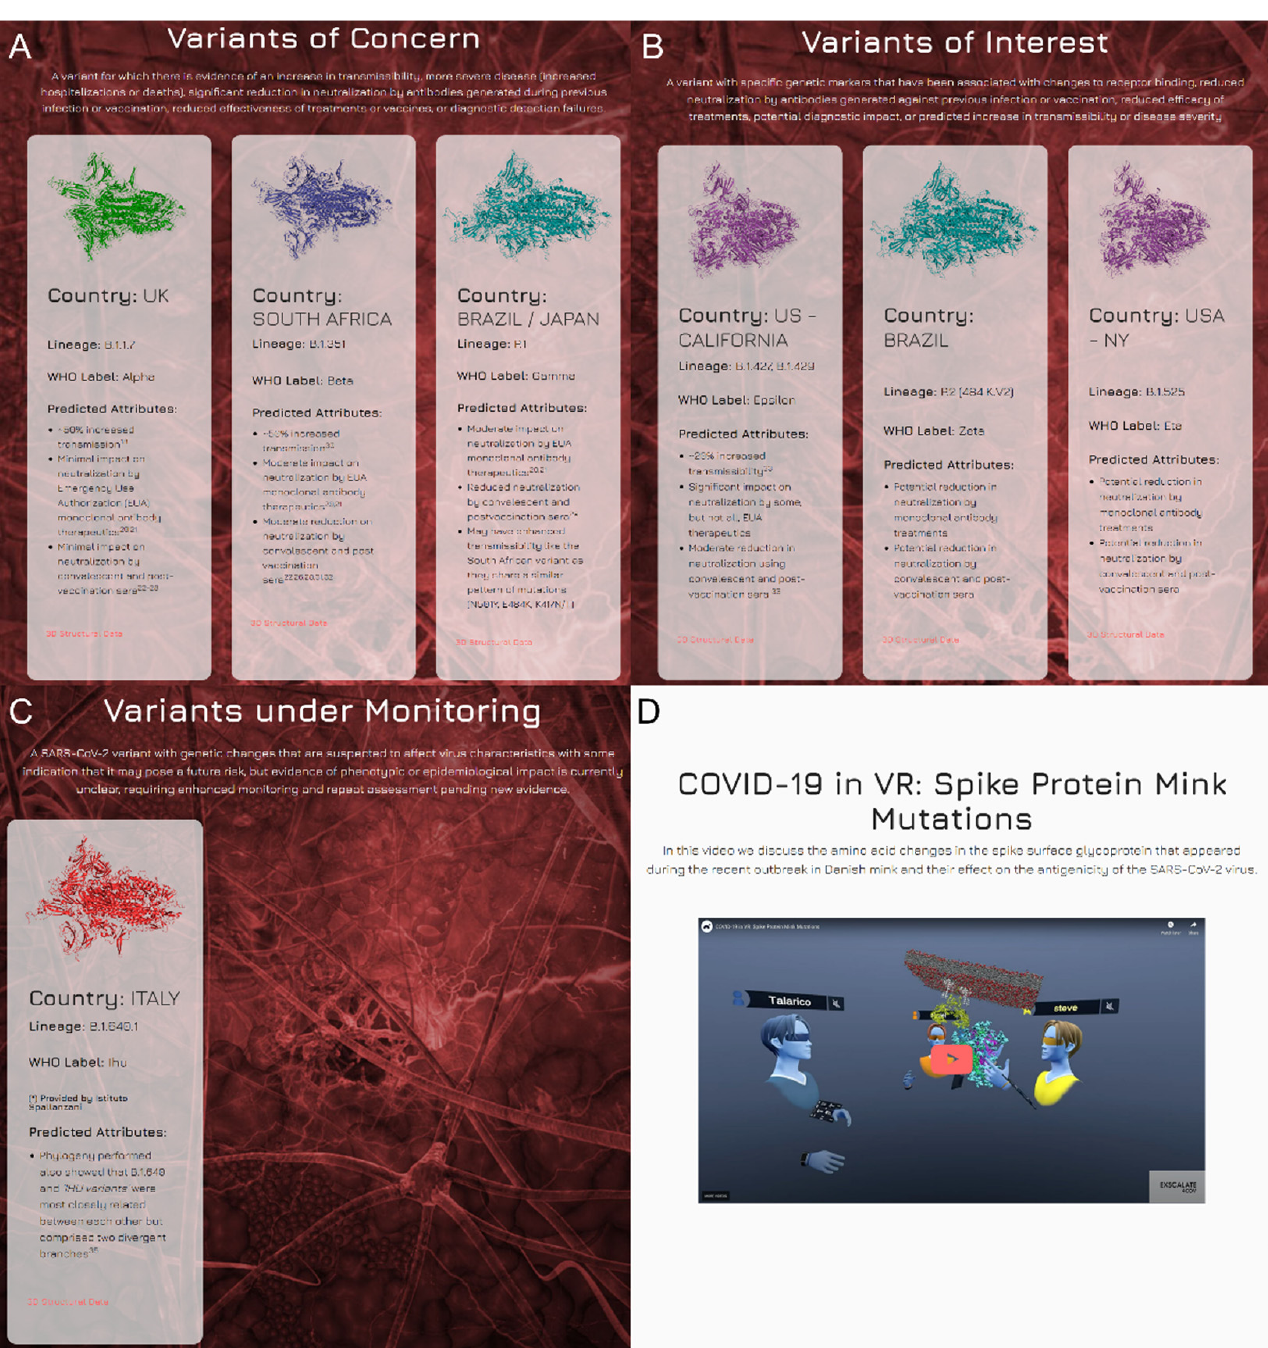
Figure 2. Snapshot of the Spike Mutants portal portions where the 3D structures of the spike protein unglycosylated variants can be freely downloaded. ( A ) “Variants of Concern” section; ( B ) “Variants of Interest” section; ( C ) “Variants under Monitoring” section; ( D ) virtual reality video of a 3D model of the S protein in interaction with the human receptor ACE2 embedded in a membrane bilayer.